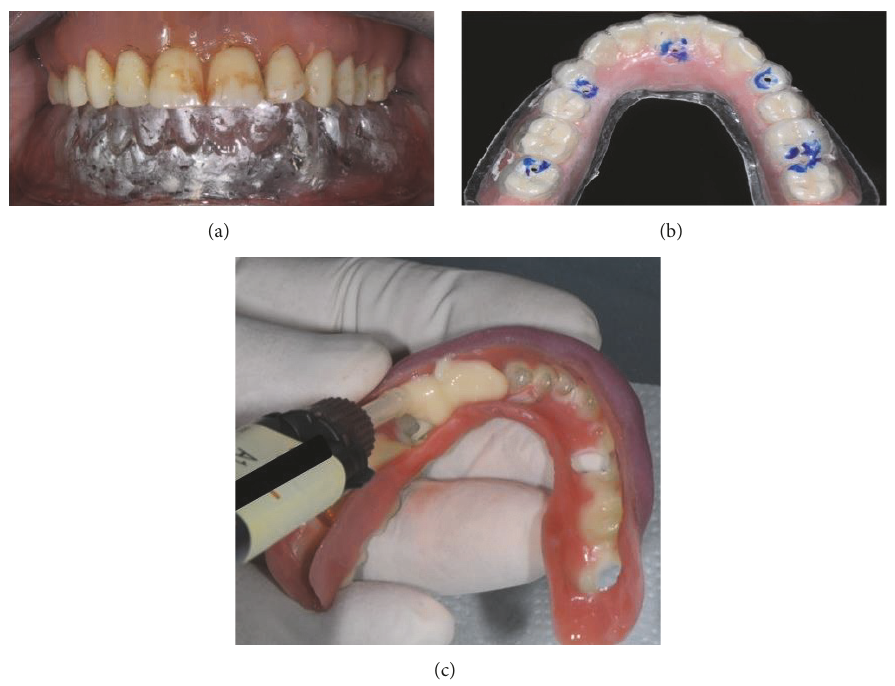
Figure 9: The vacuum-formed template was placed over the bar to control the occlusal fairness and to verify the previously measured vertical dimension (a). Holes were made on the prosthesis, using the vacuum-formed template already perforated in the direction of the cylinders, in order to access to the cylinders themselves (b). The prosthesis was relined with composite resin flow (c).